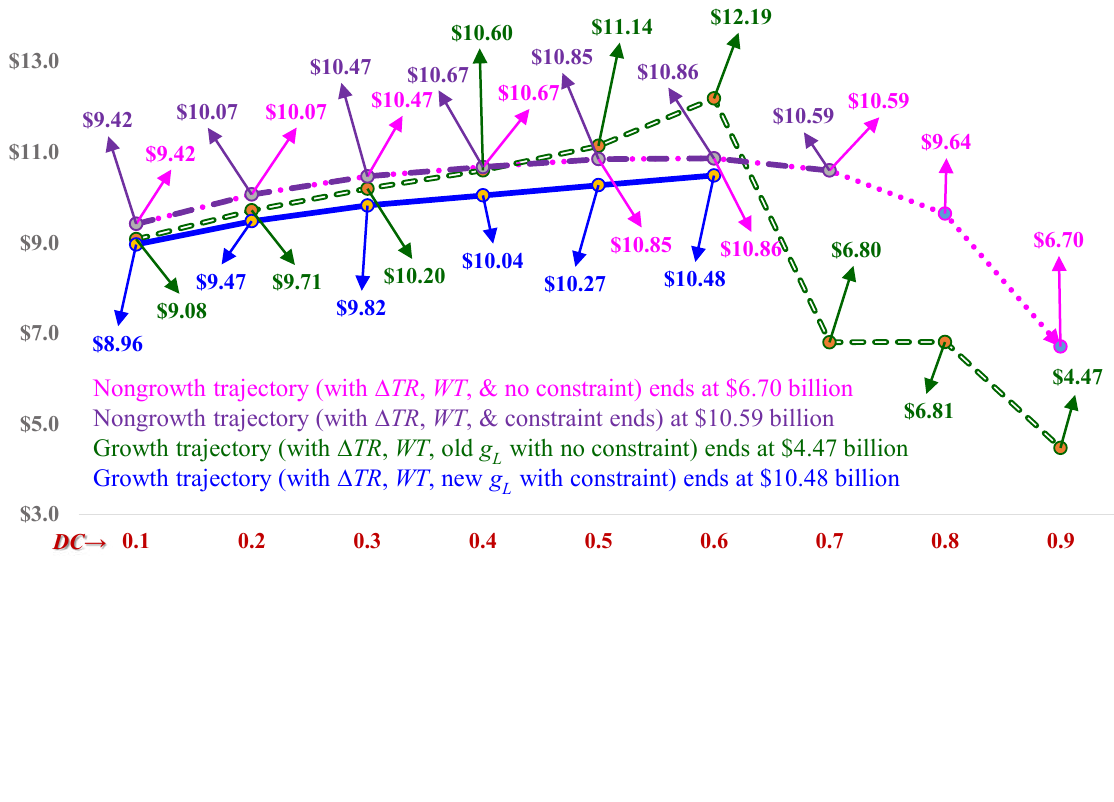
with no constraint) ends at -$3.88 billion L with constraint) ends at $2.13 billion L